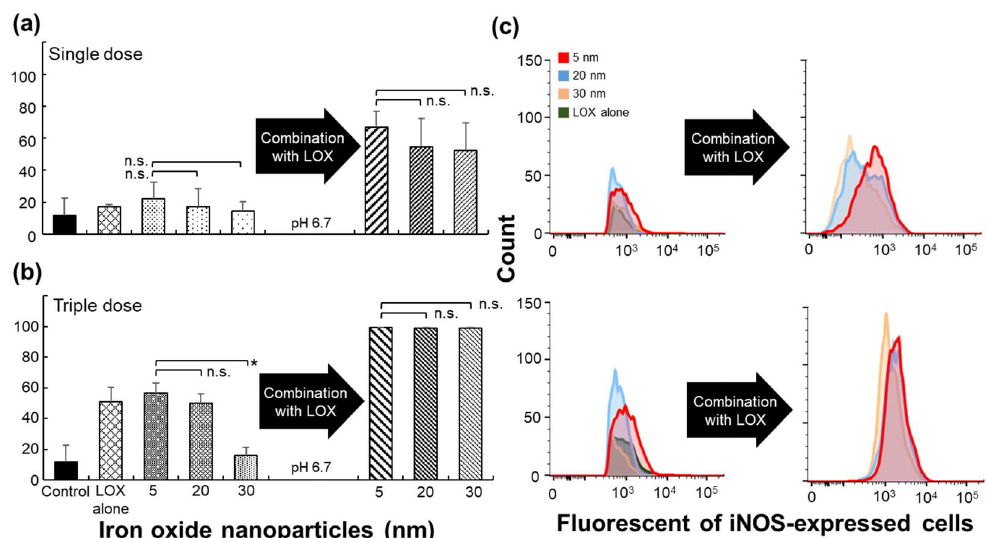
Figure 5. Repolarization of M2 to M1 macrophages. Percentages of M1 macrophages starting from M2 macrophages treated with various treatments at single doses ( a ) and triple doses ( b ) examined by flow cytometry (* p < 0.005; n.s., not significant, two-tailed unpaired Student’s t -test). Surface biomarkers, such as F4/80, iNOS, and CD206, were recognized macrophages of M1 or M2. The bars represent the mean ± standard deviation ( n = 4). ( c ) Representative FACS results of ( a , b ).